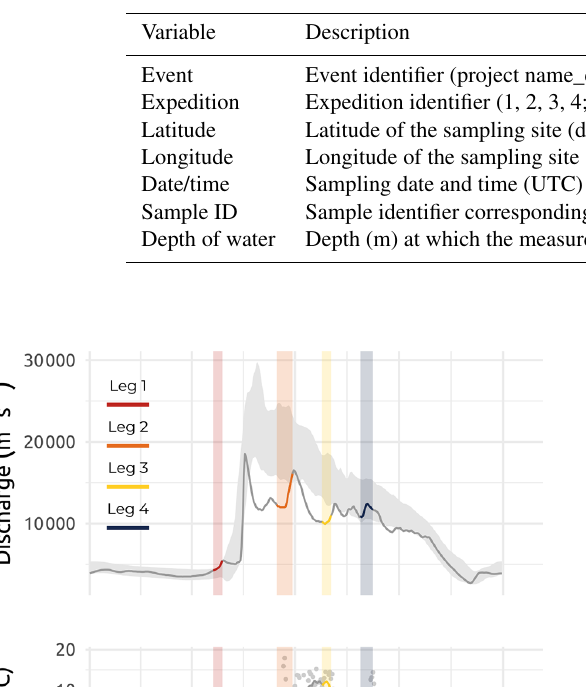
manufacturer gives an initial accuracy of ± 0 . 003 mS cm − 1 ± 0 . 05 % for the sensors’ maximum depth (i.e., 0.05 m for model that have been used; see